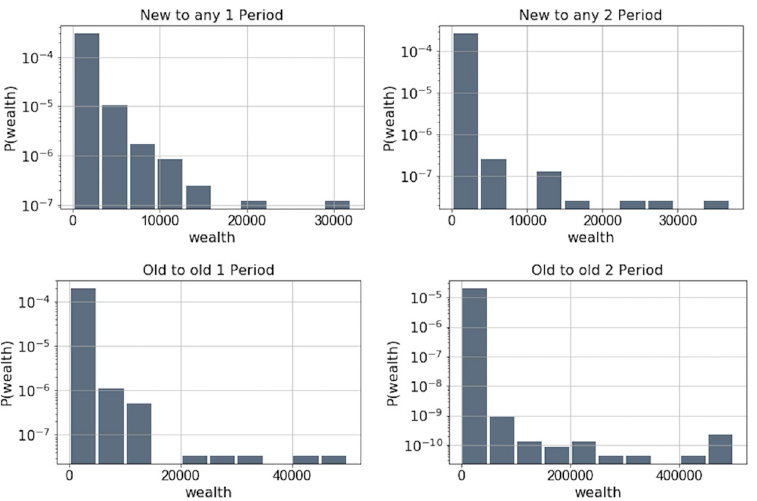
Fig 11. Normalized wealth attachment probabilities for attachment to new and old (existing) nodes in both periods. We can see that for both new and old nodes, there is no clear preference to attach to the richer nodes.